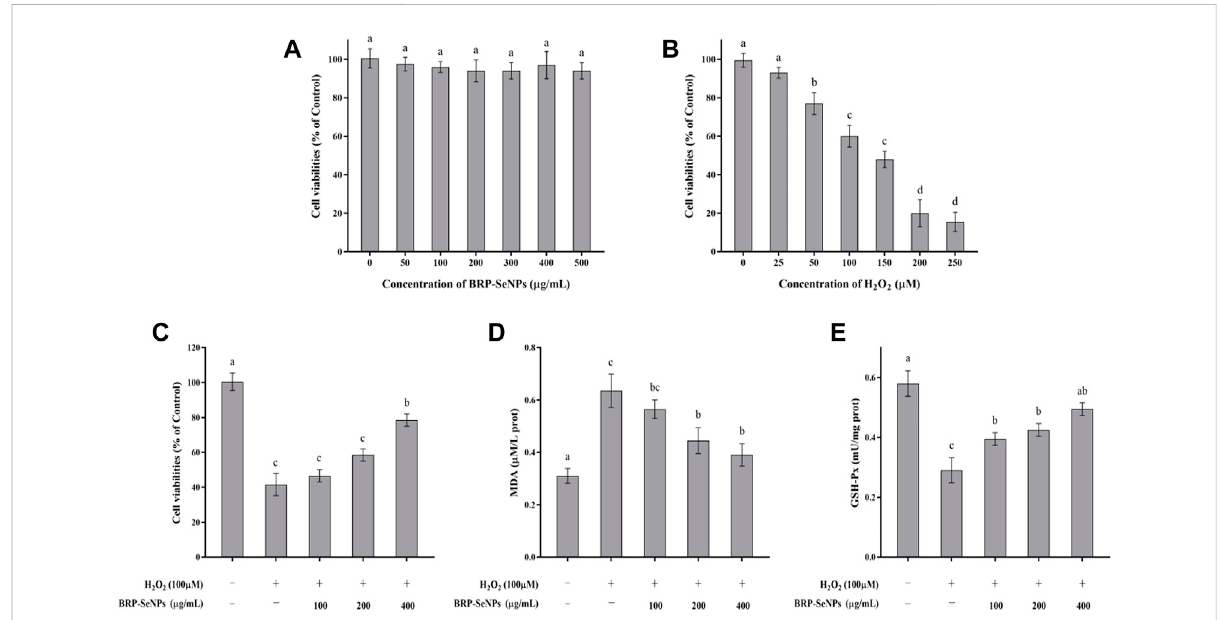
FIGURE 4 (A) EvaluationoftoxicityofBRP-SeNPsonAML-12cells. (B) Test ofH (C) ProtectiveeffectofBRP-SeNPson 2 O 2 concentrationonAML-12cells. the H 2 O 2 -induced AML-12 cells model. (D) Effect of BRP-SeNPs on the level of MDA on H 2 O 2 -induced AML-12 cells model. (E) Effect on the activity of GSH-Px on H 2 O 2 -induced AML-12 cells model. The different letters indicate signi fi cant differences ( p <